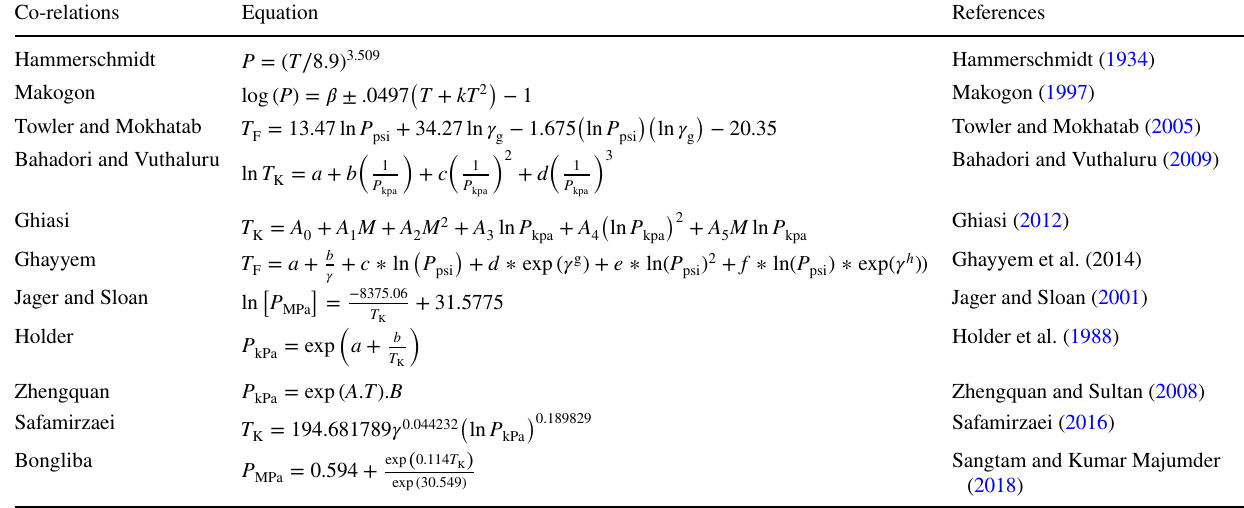
Table 6 Equations for different correlations for methane (CH Co-relations